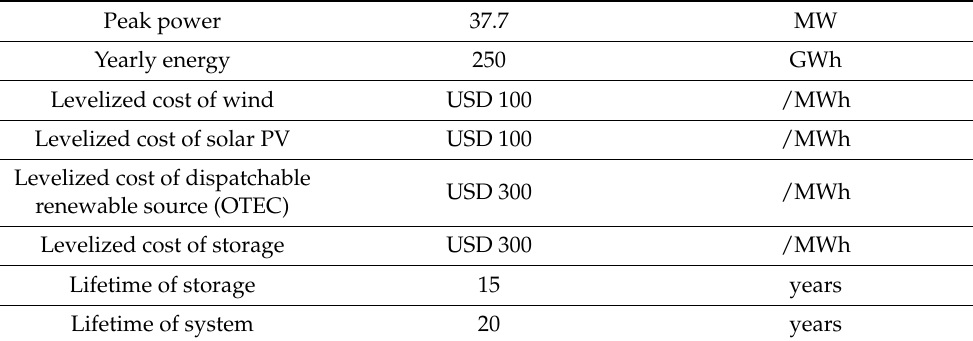
Table 2. Parameters for the evaluation of system levelized costs of electricity (sLCOE) for different combinations of solar photovoltaic (PV), wind, dispatchable renewable and